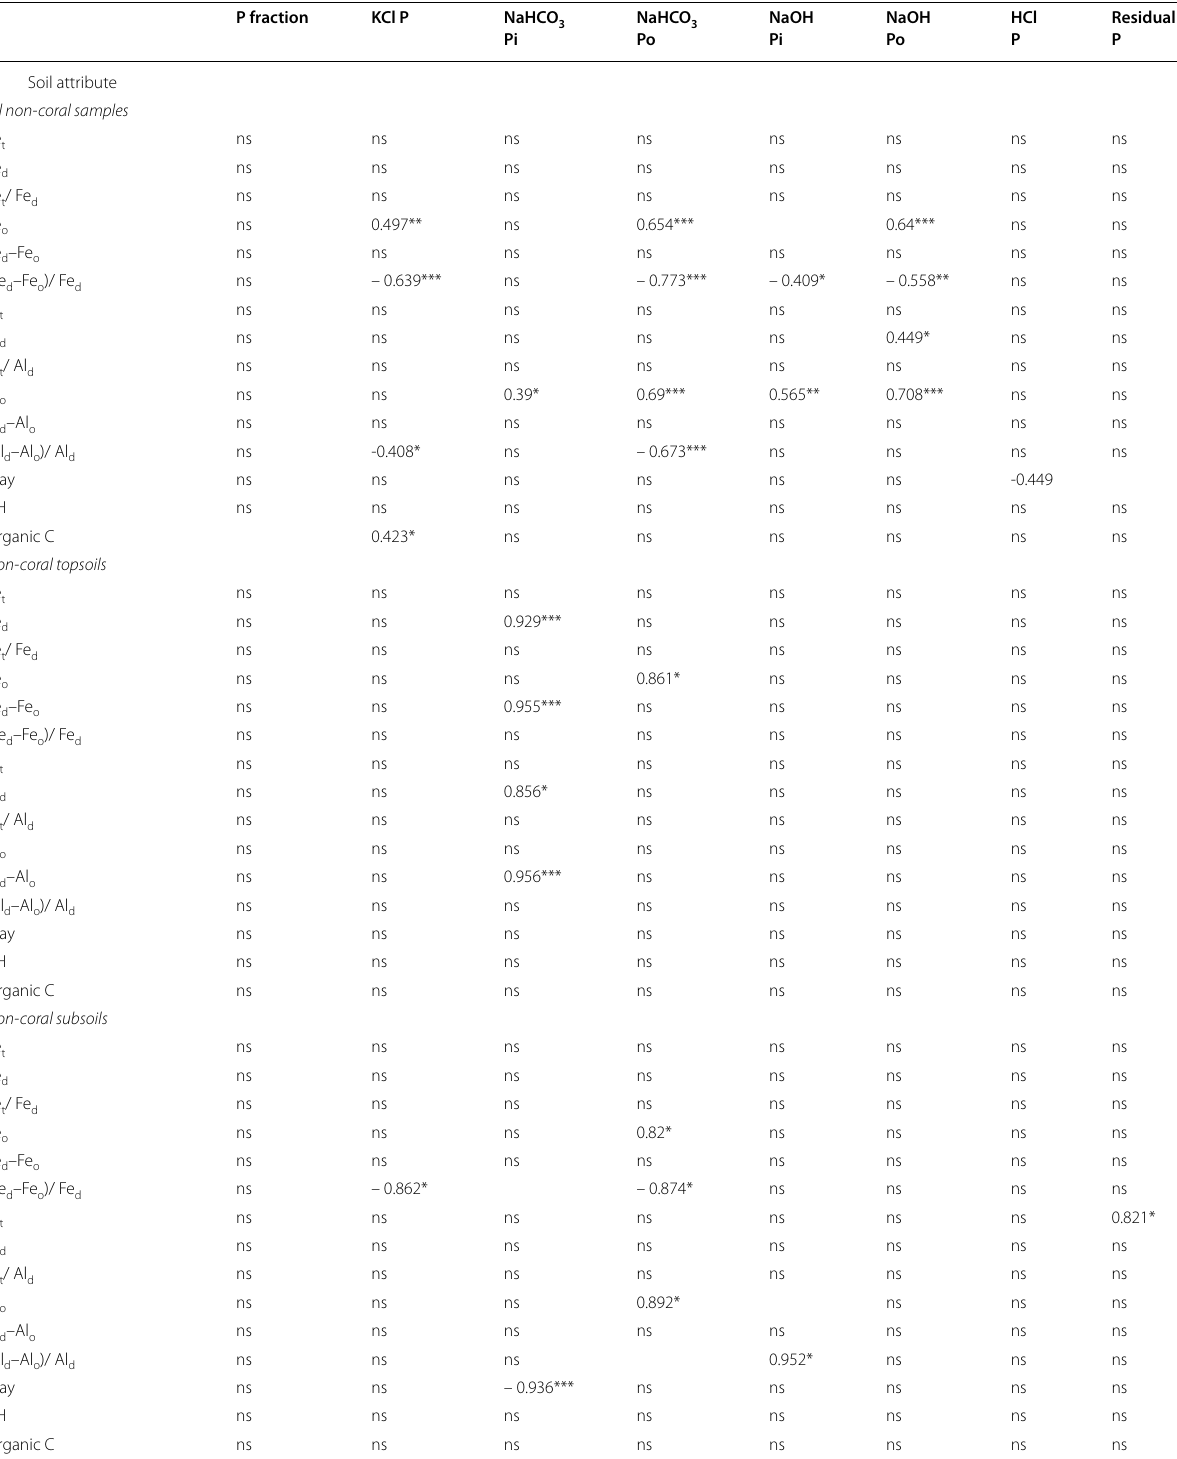
Table 4 Significant correlations between sesquioxides and P fraction in soils of Green Island